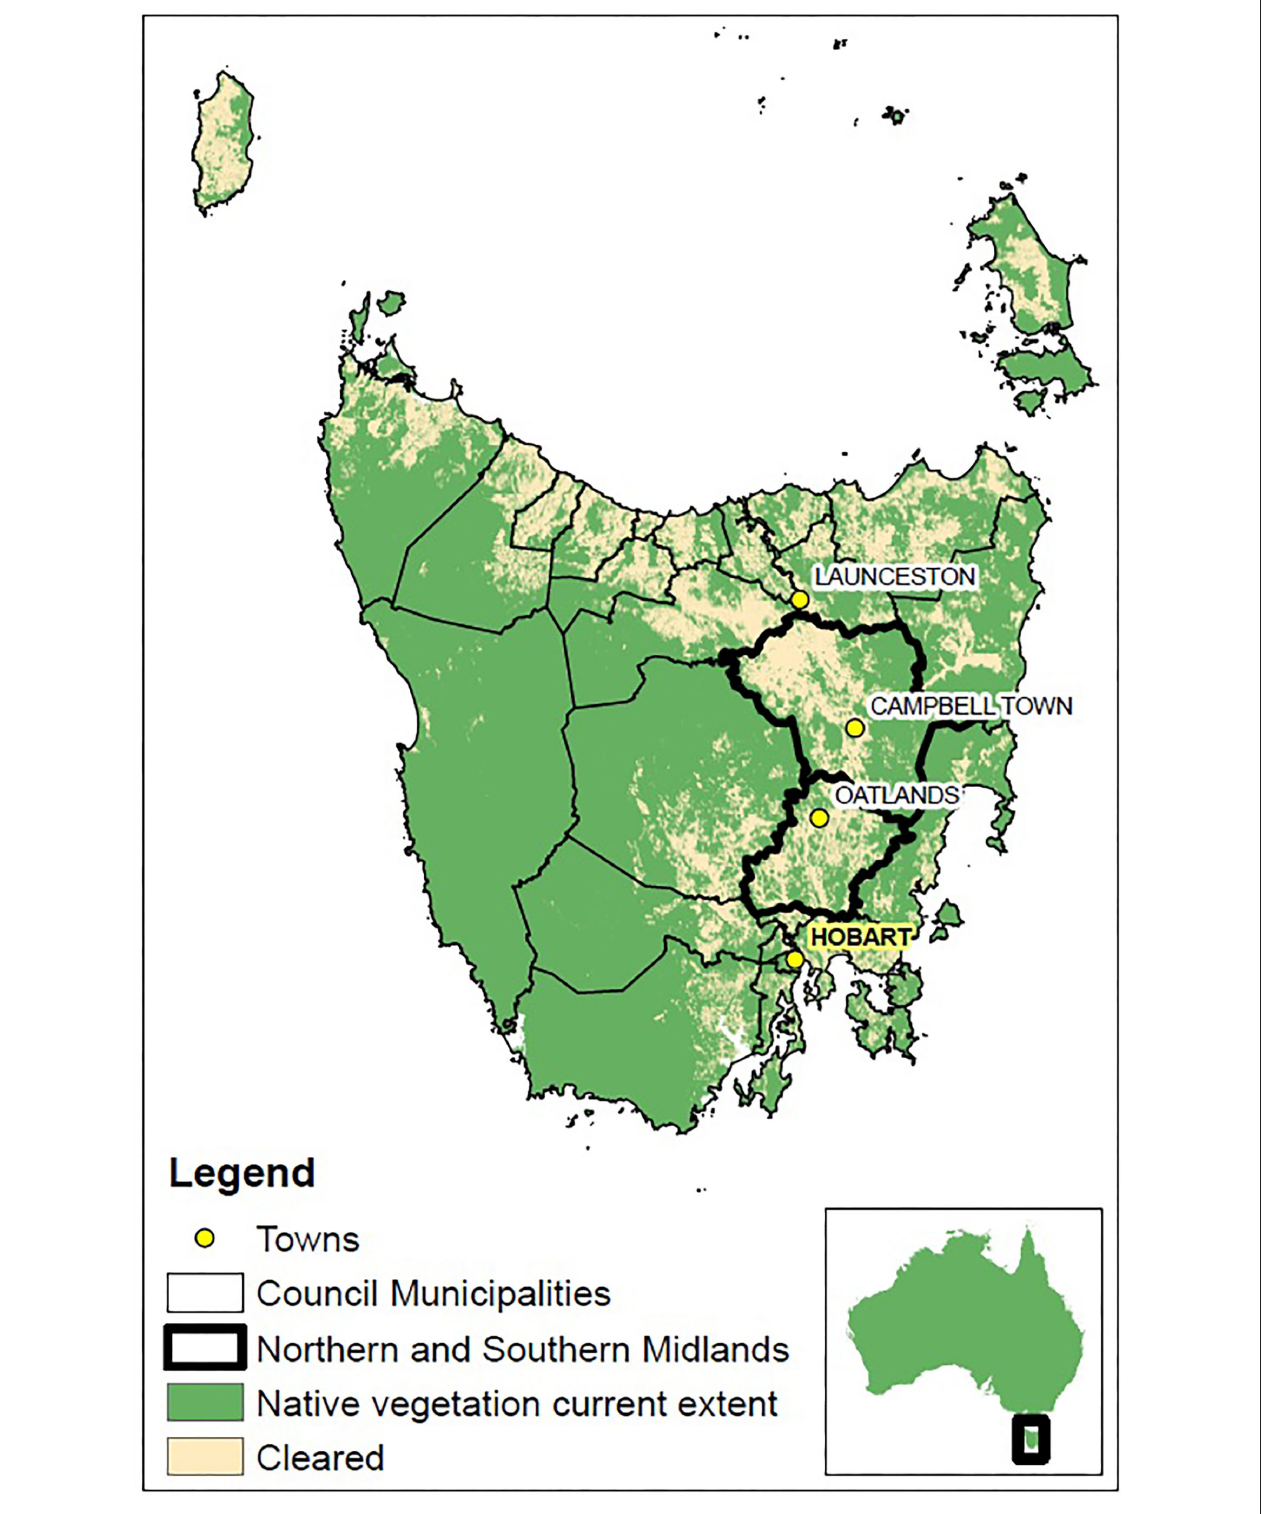
FIGURE 1 | Map of Tasmanian state council municipality borders, depicting the study area of the Northern and Southern Midlands highlighted in bold. Key towns in the state and study region are given, the capital city Hobart is given in bold and highlighted [Map data sources: National Vegetation Information System (NVIS)—Department of Agriculture, Water, and the Environment (2018); LISTdata—Department of Primary Industries, Parks, Water and Environment (2012)].